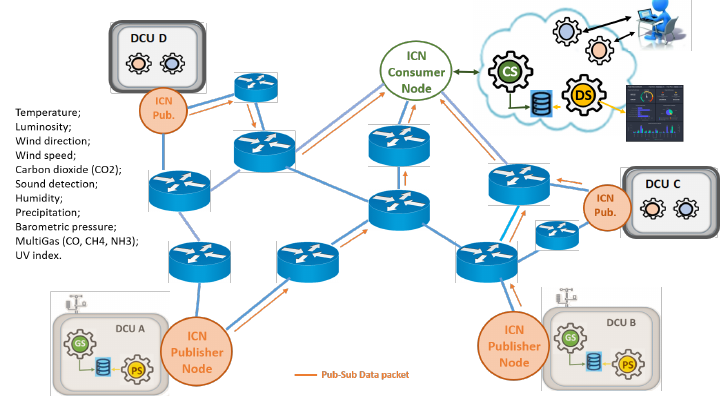
Figure 8. ICN IoT Platform with pub-sub services